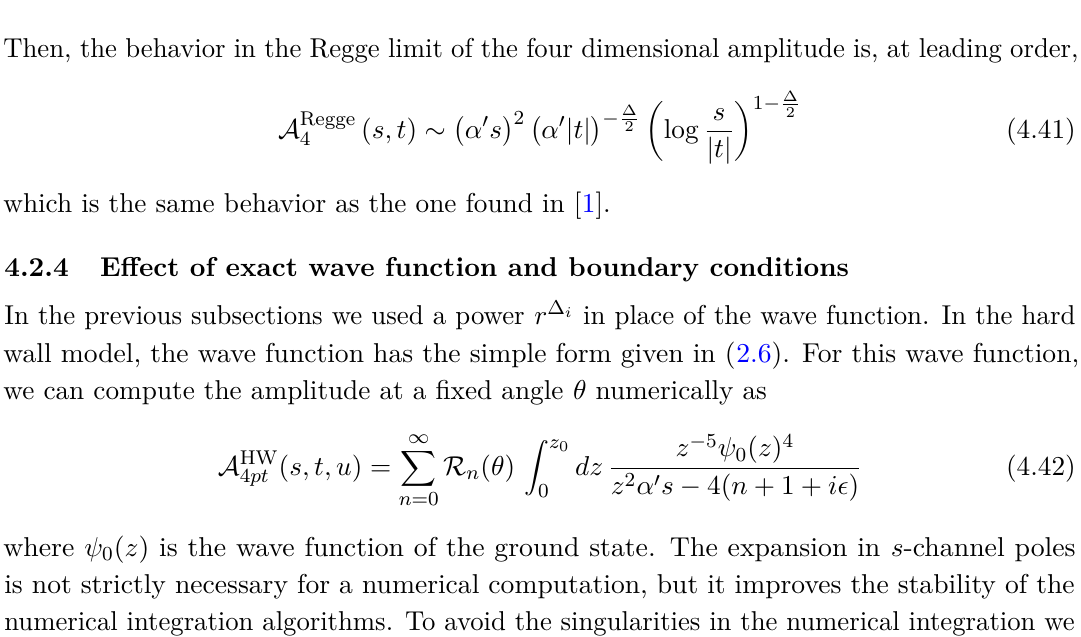
Figure 3 . Top: real (blue line) and imaginary (orange) parts of the amplitude computed in the hard wall model. The parameters used are cos θ = 0 . 8 , κ = 3 . 832 , and (cid:15) = 0 . 005